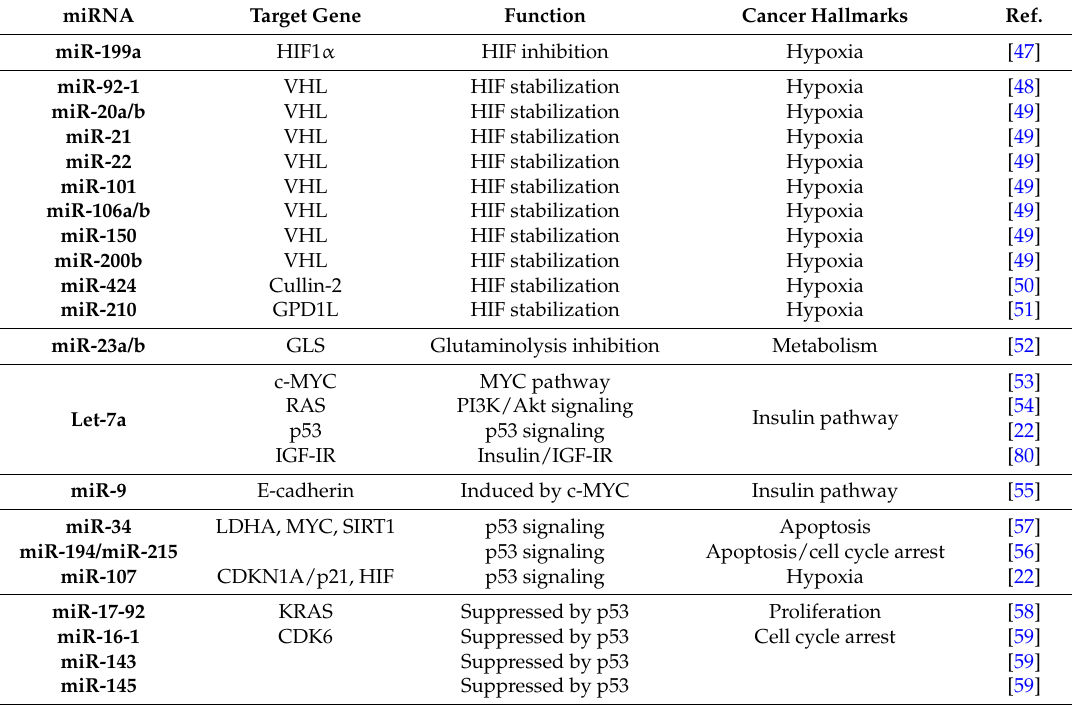
Table 1. miRNAs regulating signaling